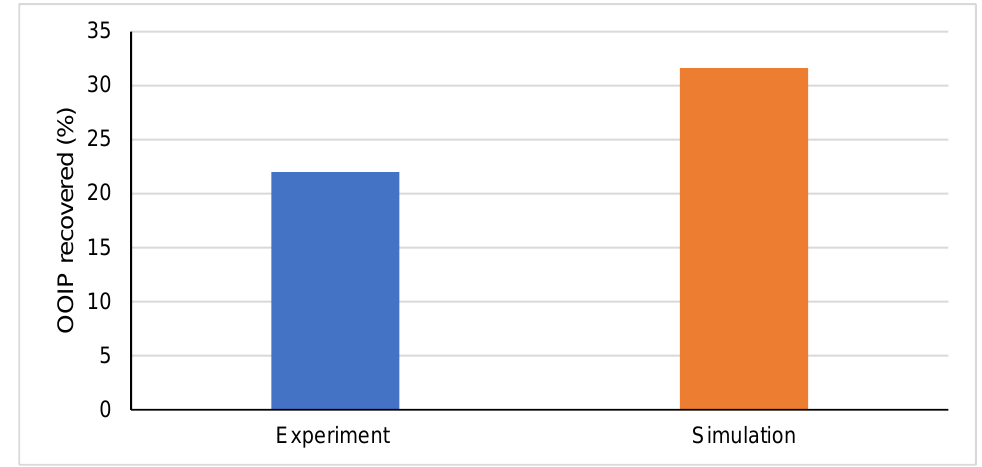
Figure 5. Comparison of OOIP recovered from the simulation and experiment.